Question: What kind of plot is shown here?
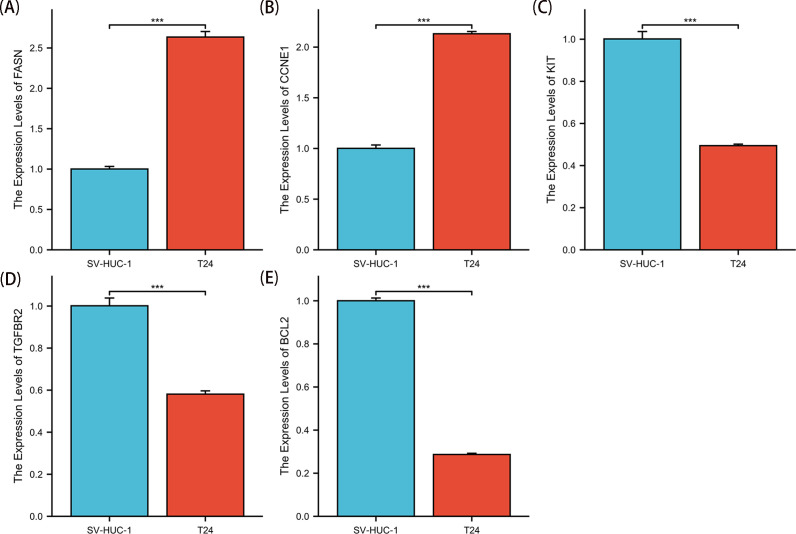
Answer: bar